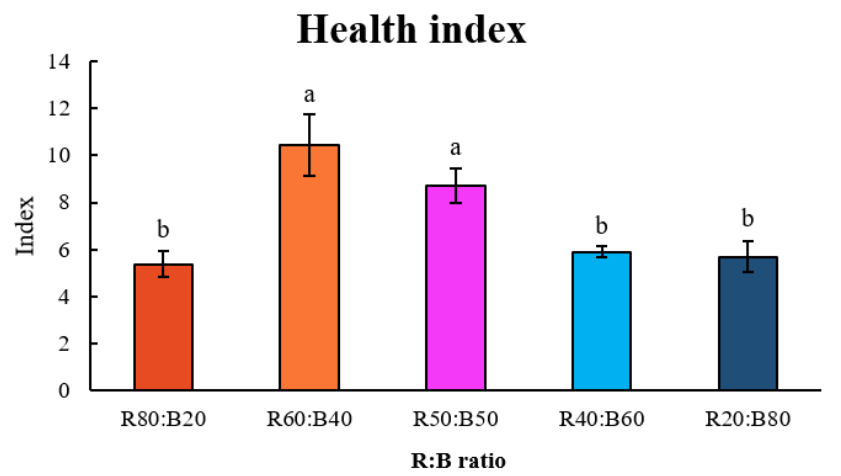
Figure 1. The effect of R:B ratio on health index of tomato seedling. The tomato seedlings were recorded at 14 days after planting. Mean and standard error are calculated from four replicates and values with different letters in each treatment are significantly different at p ≤ 0.05.